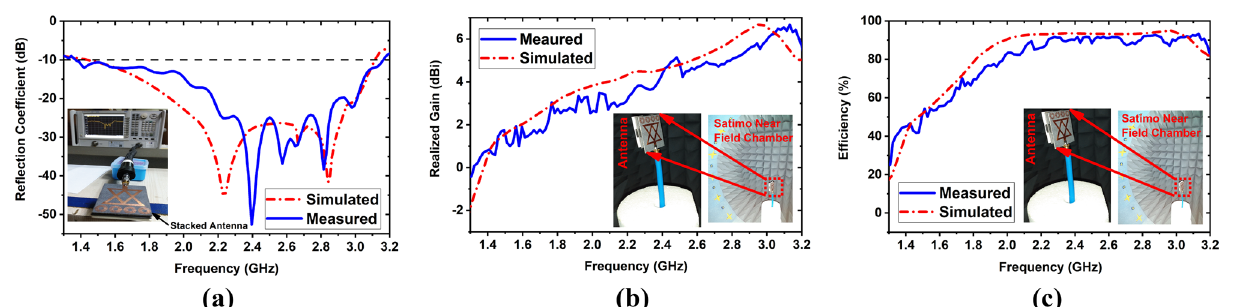
Figure 9. Simulated and measured outcomes of the proposed fabricated antenna: ( a ) Reflection coefficient; ( b ) Realized gain; ( c )